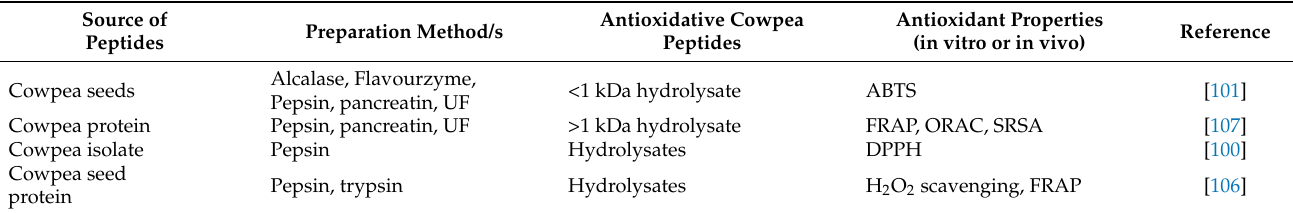
Table 4. Antioxidant properties of cowpea-derived